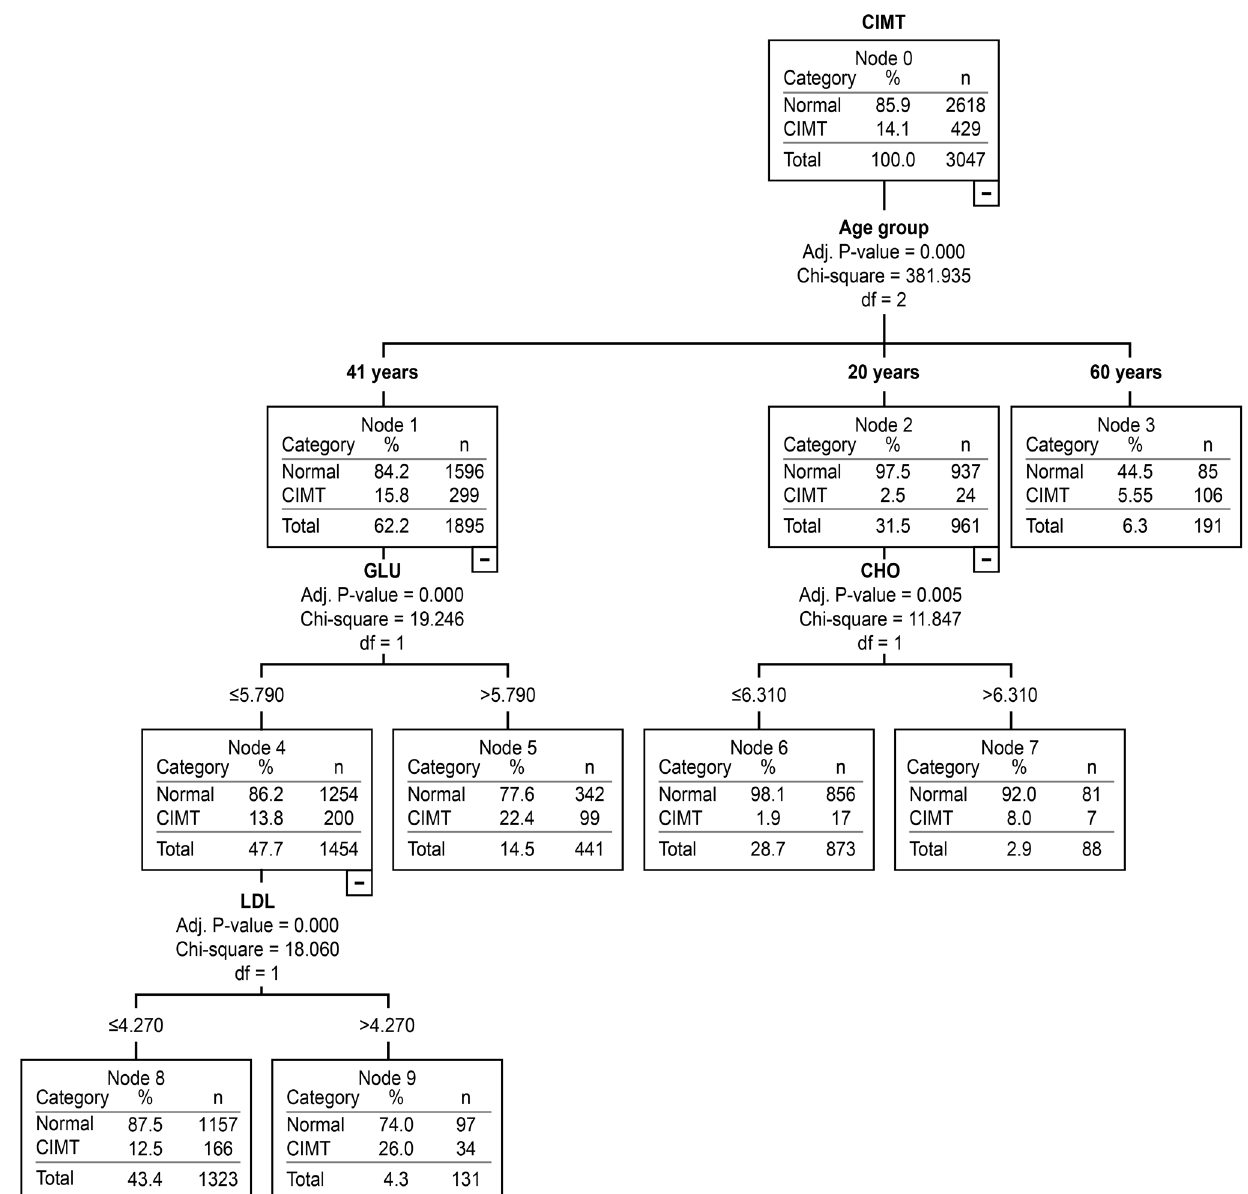
Figure 2. The assessment of traditional risk factors in men for carotid atherosclerosis in different age groups using decision tree